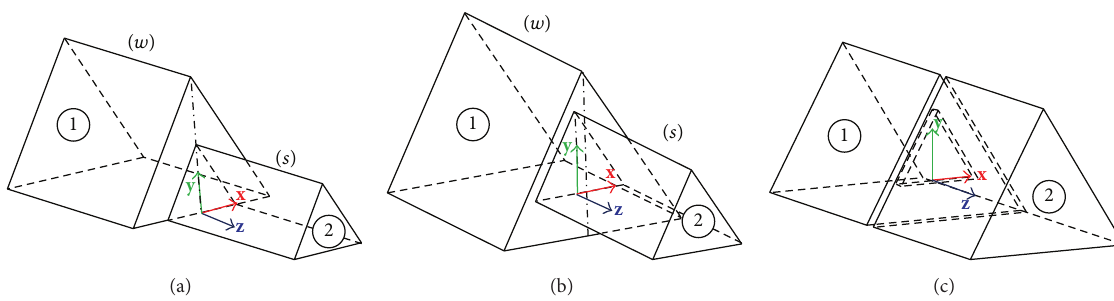
Figure 6: Case studies: single step (a) without offset and (b) with offset and (c) double step with offset.